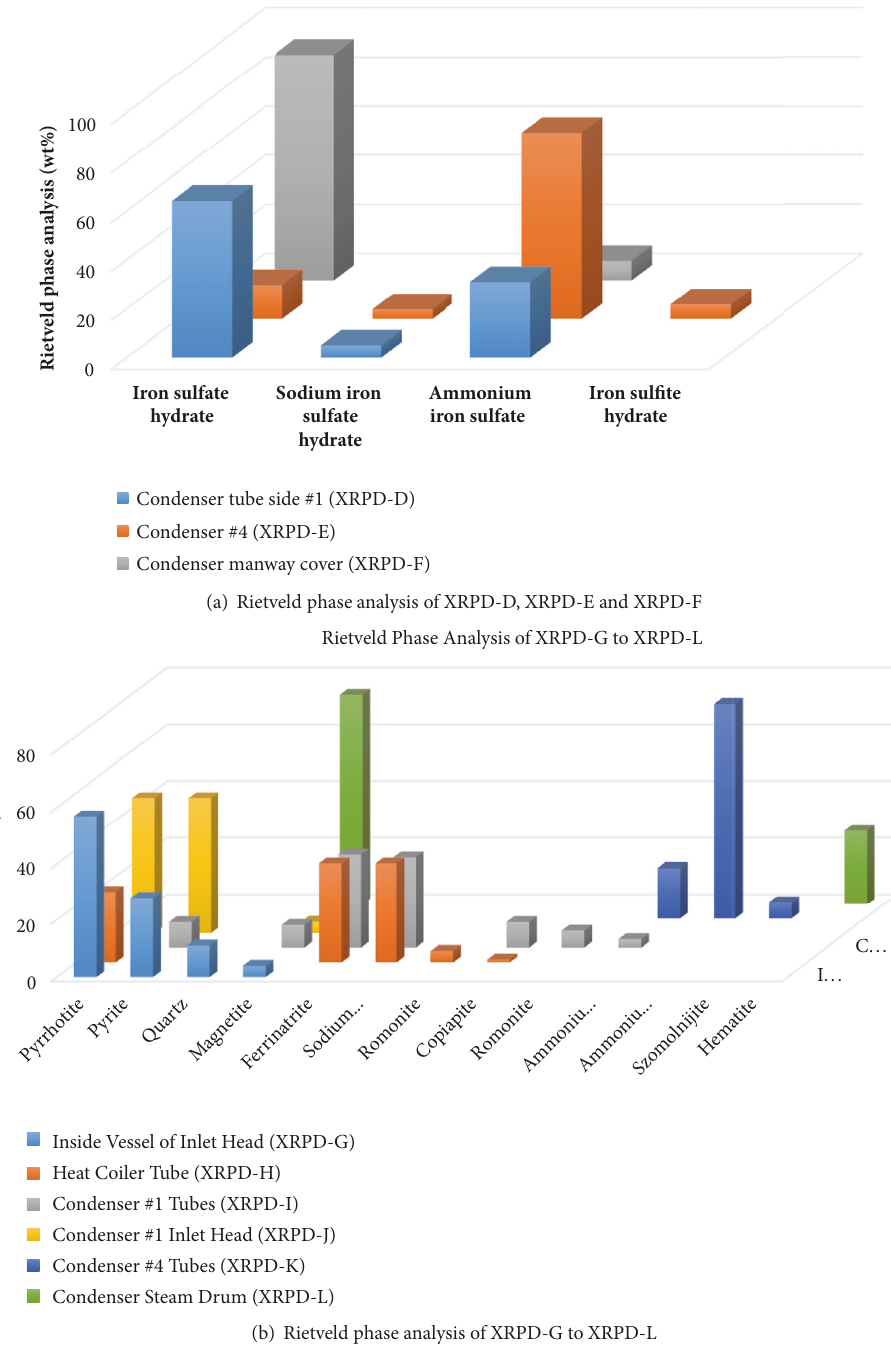
Figure 5: Rietveld phase analysis results (i.e., wt% of the identified phases) of the inorganic deposit buildup in (a) the condenser tube side #1 (XRPD-D), condenser #4 (XRPD-E), and condenser manway cover (XRPD-F), and (b) the inside vessel of the inlet head (XRPD-G), head coilertube(XRPD-H),condenser#1 tubes(XRPD-I), condenser#1 inlet head (XRPD-J),condenser#4 tubes(XRPD-K),and condenser steam drum